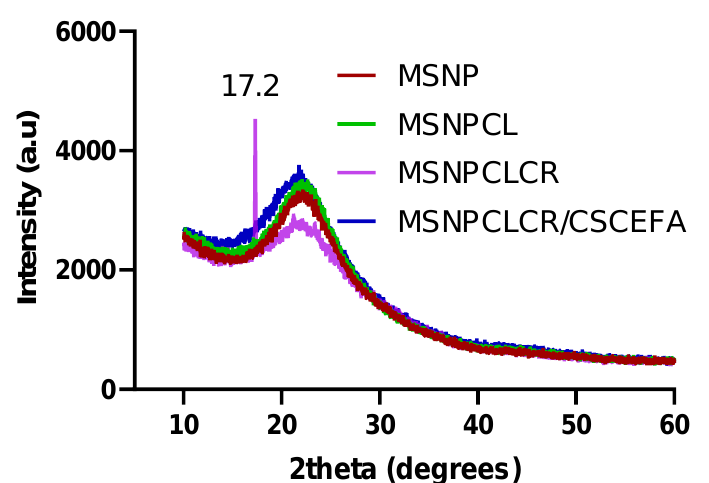
Figure 2. The XRD patterns for MSNP and nanoformulations before and after the coating with CS-CE-FA conjugation. One crystalline peak at 2 θ : 17.2 is related to CR loading; the peak disappeared after coating.